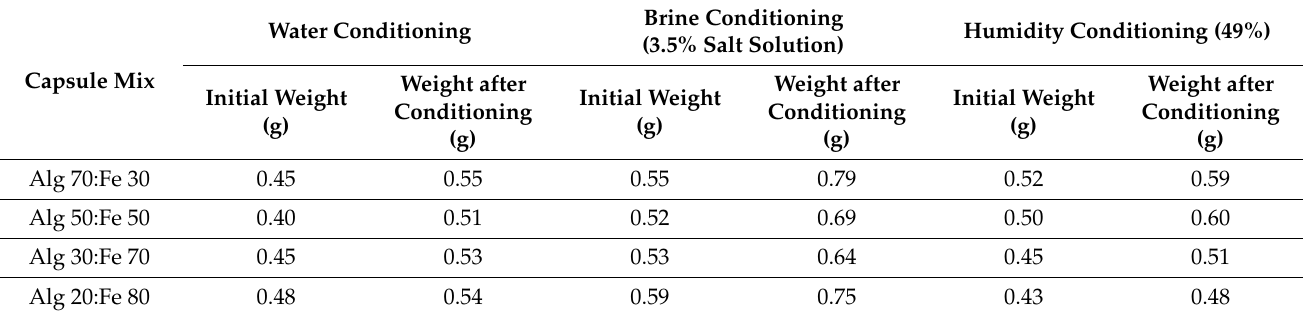
Table 4. Capsule induction heating results.